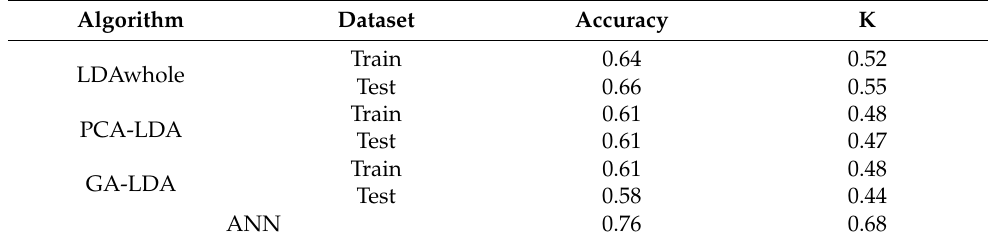
Table 2. Accuracy and kappa values for the LDA and ANN classification